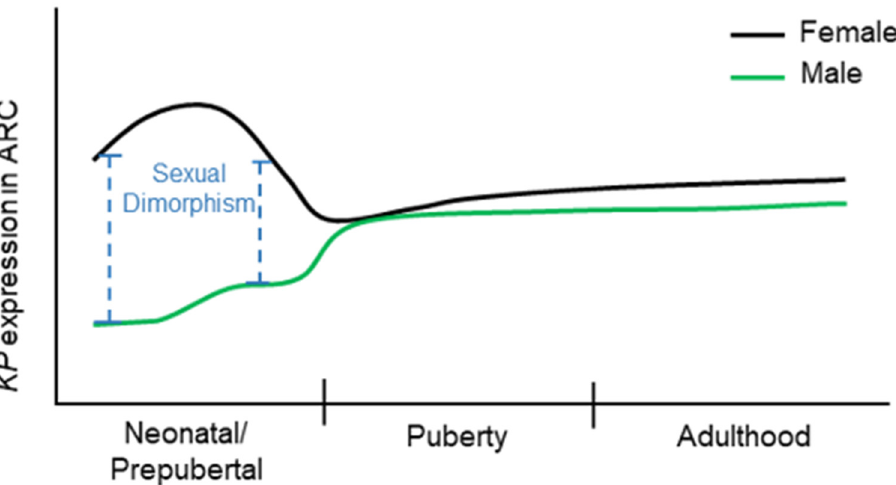
Figure 4. Kisspeptin expression in arcuate nuclei. The changes in kisspeptin (KP) expression in females (black line) and males (green line) were traced through the neonatal/prepubertal periods, the pubertal period, and the adulthood in previous studies. There is a high degree of sexual dimorphism in KP expression in the arcuate (ARC) nuclei during neonatal and prepubertal period. The sex-specific dimorphic expression of KPs in ARC nuclei sustains until the onset of puberty when the levels of KP expression become